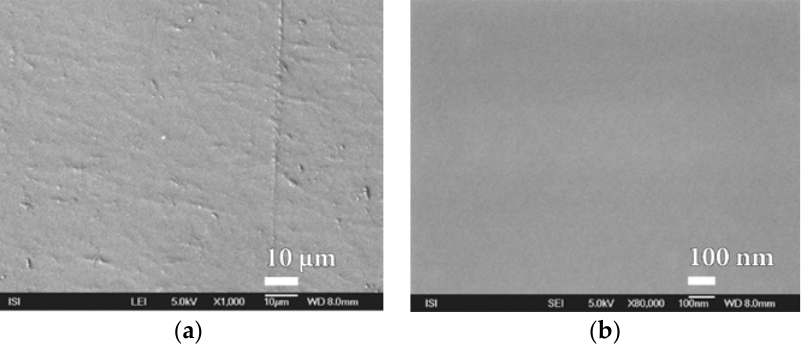
Figure 7. The exhibitions of different inhomogeneity on the surface of the used polymer foil PEVA at various magnifications of ( a ) 10,000×; ( b ) 30,000×;( c ) 5000×.